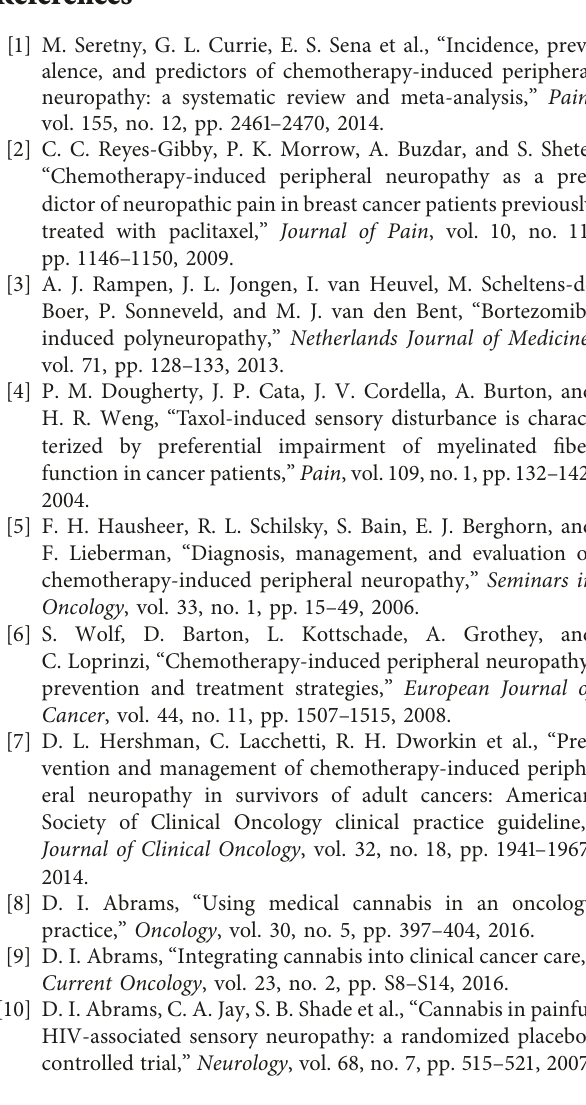
NSAID, nonsteroidal anti-inflammatory